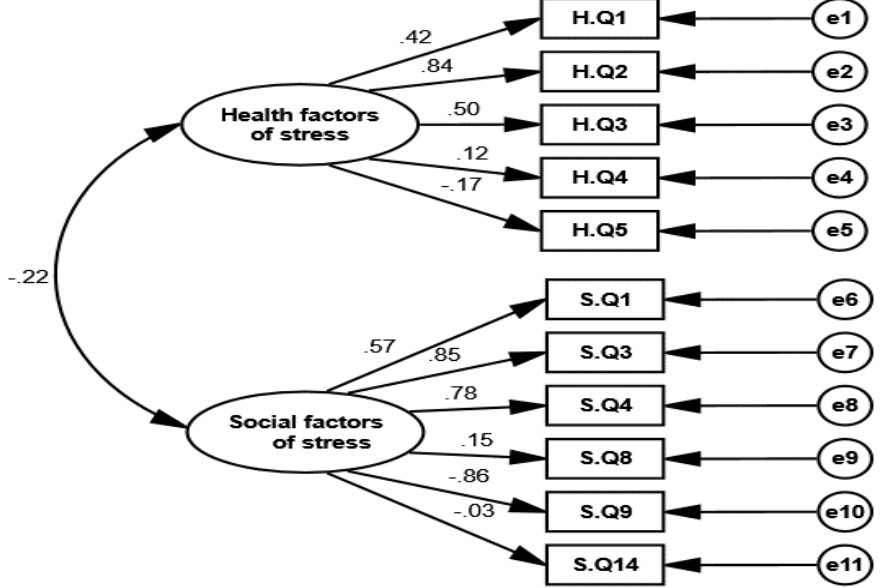
Figure 15. Standardized estimates of health and social factors.